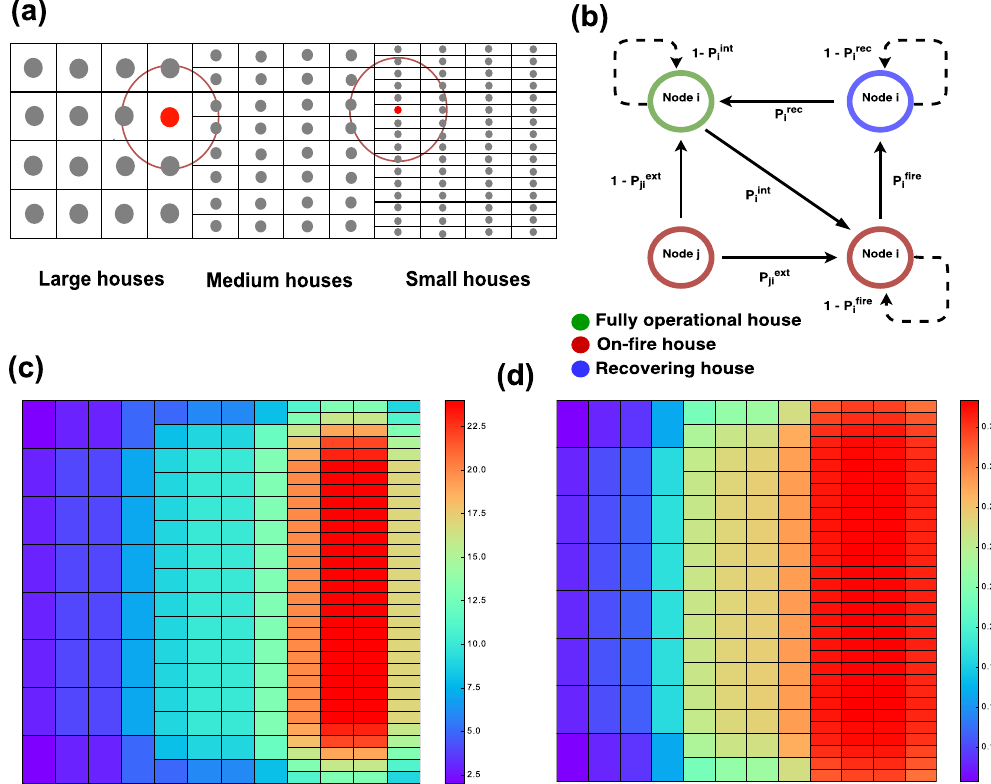
Figure 1. ( a ) Basic block of a city. A sample city consists of four basic blocks. Three types of houses are represented as nodes. Red circles show the range of external fire spread. All houses in this circle may catch fire from the burning center node. ( b ) Fire propagation dynamics. This diagram shows state transitions. The nodes represent a fully operational house (green), a burning house (red) and a recovering house (blue). The lines show state transitions to a new state as solid lines, and state transitions to the same state as dotted lines. ( c ) House degrees in an 8 block 224 house city. The degree increases horizontally from left to right as house types change from large to medium and to small. Centrally placed small houses have the highest degrees. ( d ) Fraction of time each house is on fire. Results are averaged over 100 independent realizations. Each simulation runs 10 6 time units. The houses are fully operational initially. The simulations used parameter values listed in Table 2.